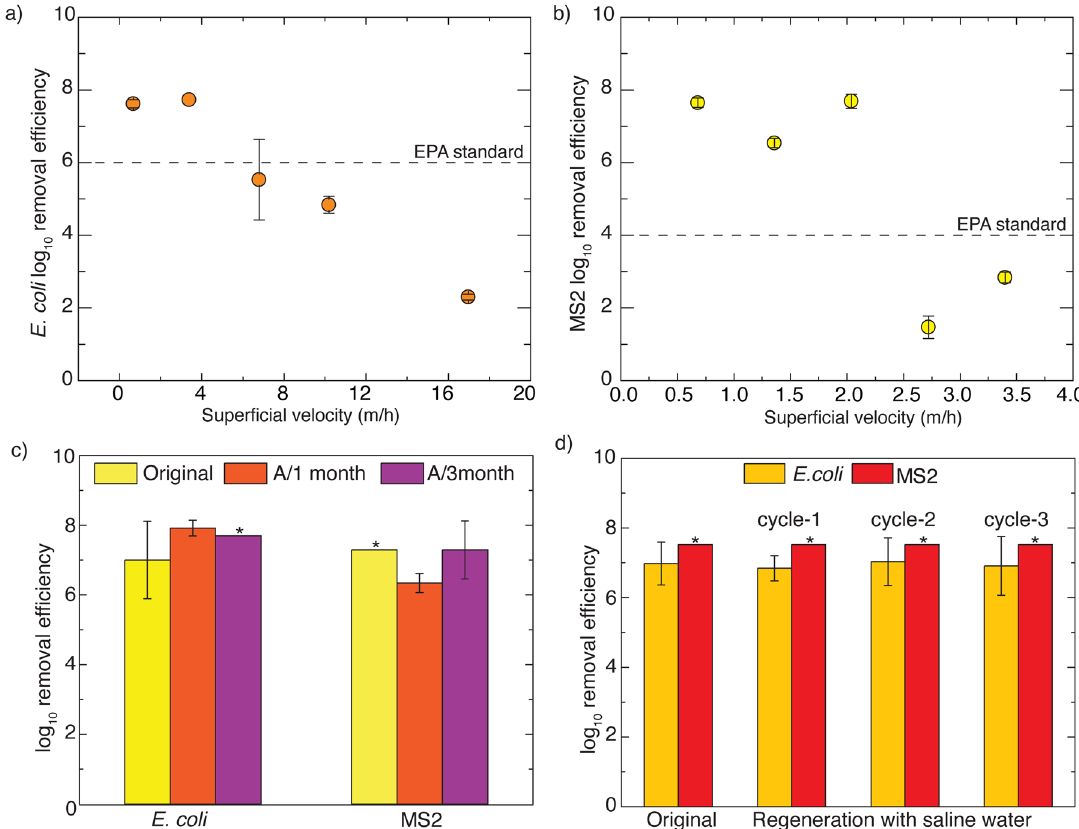
Fig. 6 MO- cotton fi lters show the potential to be a sustainable solution for virus contamination removal under practically relevant conditions for various contexts. a Experimental log 10 removal of 10 8 CFU mL − 1 E. coli in fl uent at various fl owrates in the range of 2 mL min − 1 to 50 mL min − 1 show that MO -cotton fi lters achieve >6 log 10 removals up to a fl owrate of 10 mL min − 1 . b Experimental log 10 removal of 10 8 PFU mL − 1 MS2 bacteriophage in fl uent at various fl owrates in the range of 2 mL min − 1 to 10 mL min − 1 show that MO- cotton fi lters achieve >4 log 10 removal up to a fl owrate of 6 mL min − 1 . These fl owrates correspond to super fi cial velocities of 3.4 m h − 1 and 2 m h − 1 for E. coli and MS2 removal, respectively, which are slightly lower than the typical operating conditions of rapid sand fi ltration (5 – 15 m h − 1 ) and higher than slow sand fi ltration (0.1 – 0.4 m h − 1 ). c E. coli and MS2 removal ef fi ciencies of MO -cotton fi lters at a fl owrate of 2 mL min − 1 after 1 month and 3 months of holding at room temperature. Results show that MO -cotton achieved 7.92 ± 0.22 log 10 and >7.7 log 10 removal for E. coli